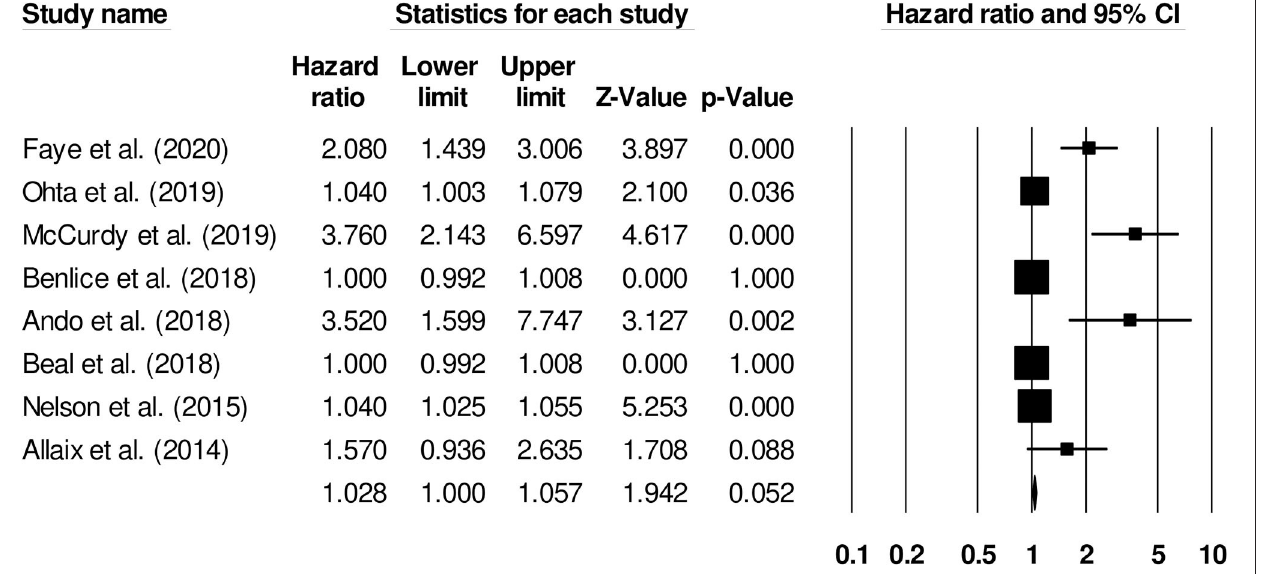
FIGURE 4 | Forest plot for studies evaluating age as a risk factor of venous thromboembolism in patients with inflammatory bowel disease. The hazard ratios are presented as black boxes; 95% confidence intervals are presented as whiskers. A small hazard ratio represents lower risks of venous thromboembolism with age, and a higher hazard ratio represents higher risks of venous thromboembolism with age in patients with inflammatory bowel